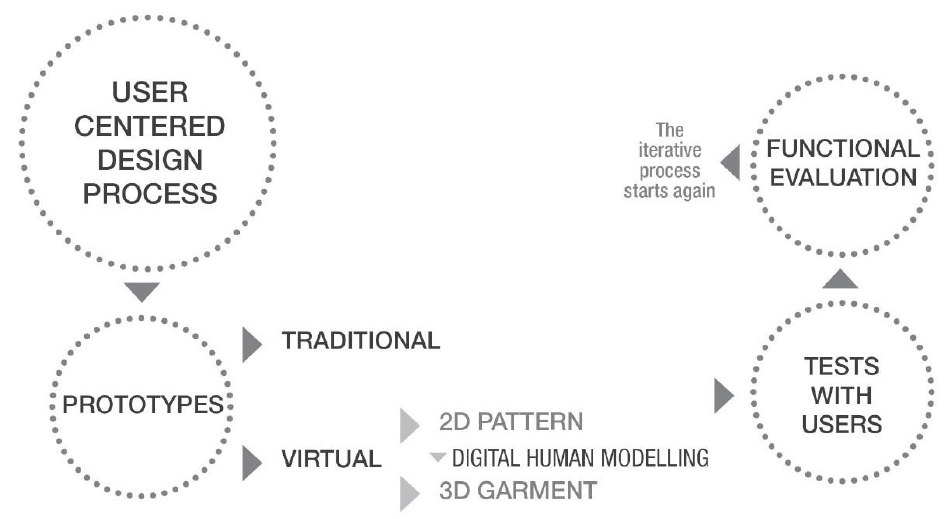
Figure 2. Digital human modeling ( DHM) contribution in passing from 2D pattern to 3D garment.